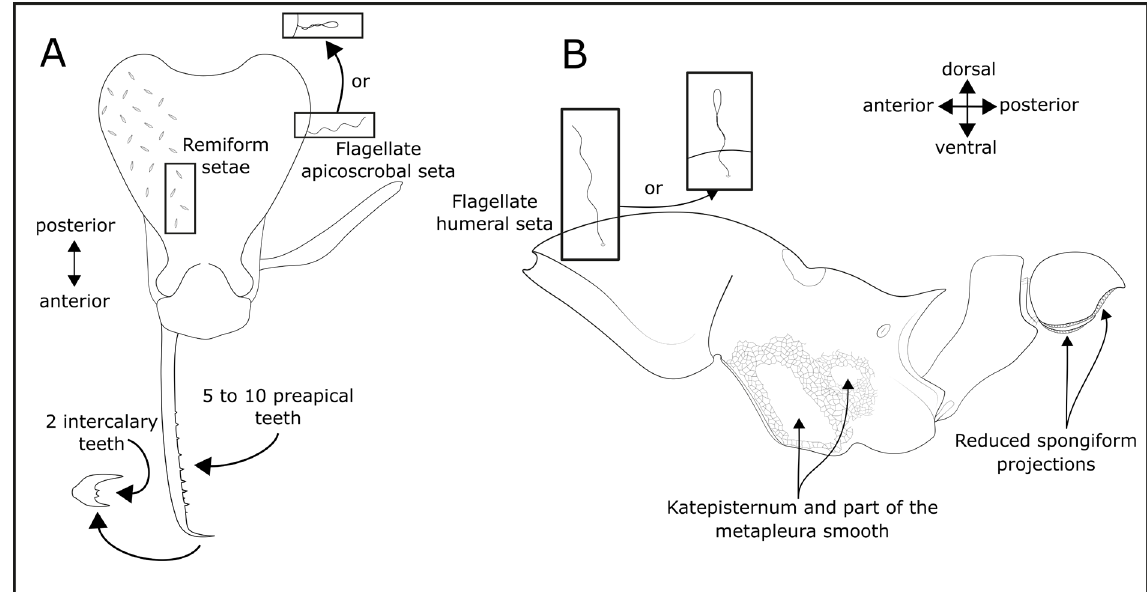
Fig. 4. Generalized schematics of Strumigenys denticulata Mayr, 1887, showing useful identification features. A . Head in dorsal view. B . Mesosoma, petiole, and postpetiole in lateral